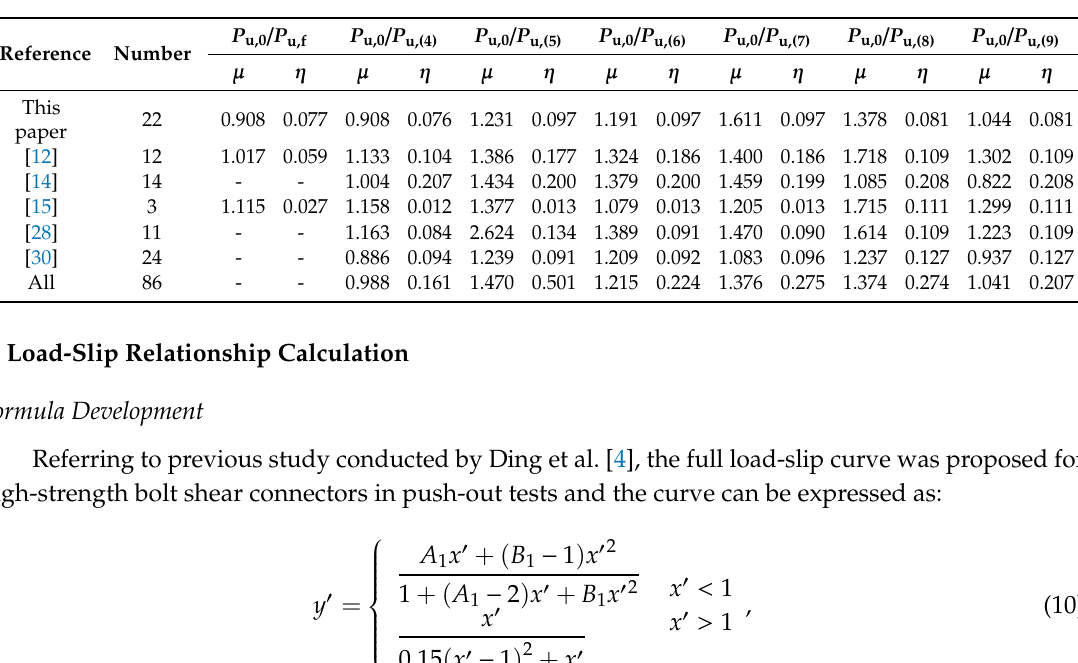
Table 5. Comparison between predicted bearing capacities and test results.